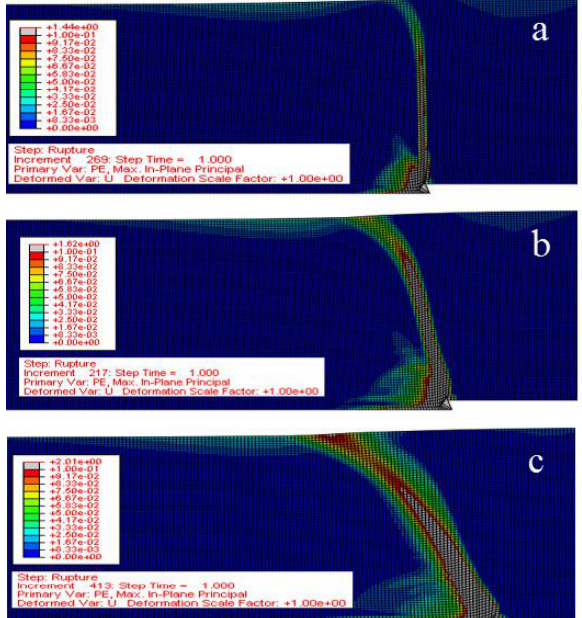
Fig. 8. Comparison of fault route angle for one-layer model without structure: (a) LS; (b) MS; and (c) DS.